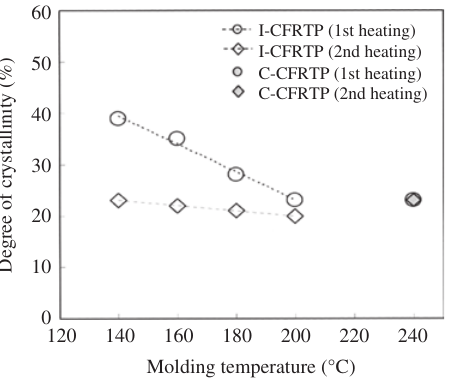
Figure 6 Effect of molding temperature on the degree of crystallin- ity for the first and second heating for I-CFRTP and